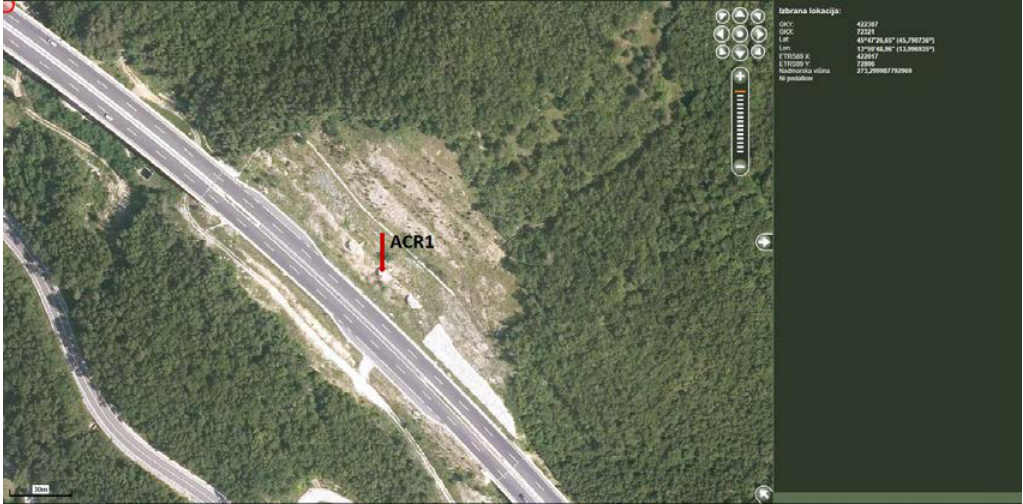
Figure 8. The GIMS Pilot Area 1: the Vipava valley (Slovenia). Location of the